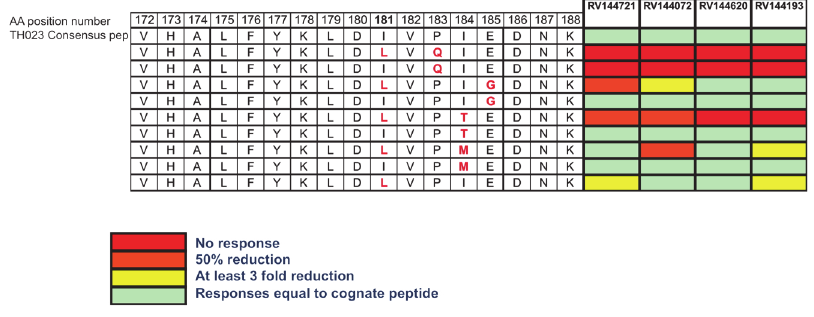
Figure 3. Peptide 32 is shown in comparison to other synthesized peptides containing sieve mutations at position 181 and other mutations (at positions 183 – 185) that were observed in the viruses found in vaccinee breakthrough infections. The heat map on the right represents the IFN- γ fold reduction response of the 4 gp120A244 specific CD4+ T cell lines to the altered peptides relative to the consensus sequence. The aa mutation P183Q, was similarly expressed between the the two arms with breakthrough HIV infections. In particular, in the 44 vaccinees, 16 were P (36%), 22 Q (50%), and 5 other residues (E,K,N,S) were also most common. For the 66 Placebo recipients, 28 were P (42%), 31Q (47%), and 7 were other residues (E,K,R,S).